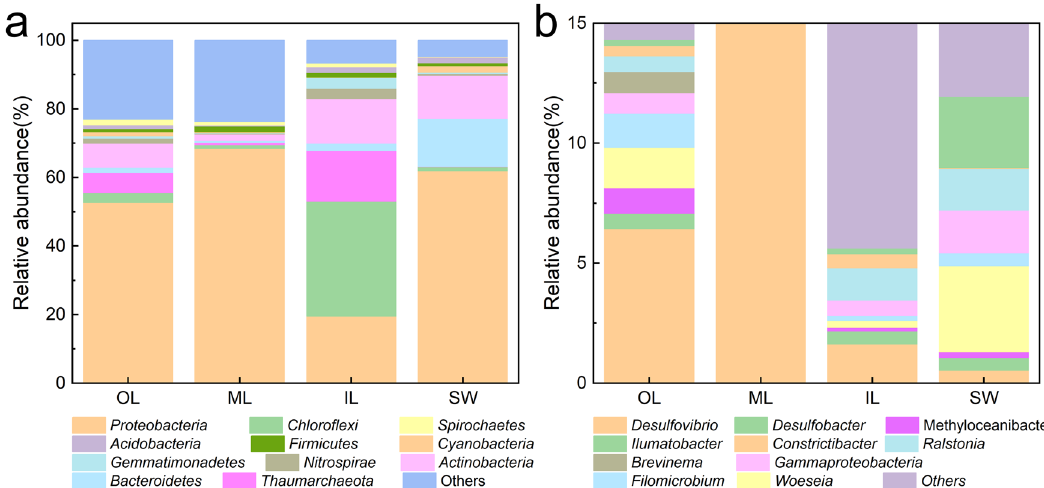
Fig. 5 Relative abundances of bacterial 16S rRNA gene sequences in the three-rust-layer corrosion products of Q345 steel. a Phylum and b genera level. OL outer rust layer rust, ML middle rust layer, IL inner rust layer, SW seawater. Table 3. Relative abundance of bacterial 16S rRNA gene sequences obtained from rust and seawater samples at the genus level (%).